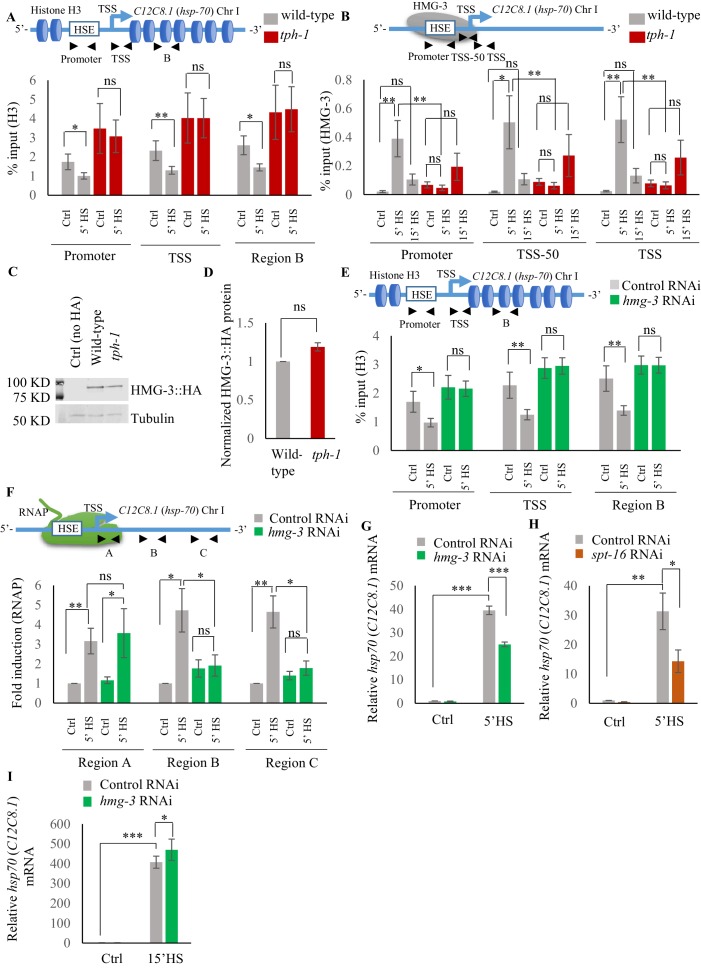
Characterizing H3 and FACT occupancy across hsp genes in wild-type and tph-1 mutant animals under control and heat shock conditions.(A) Top: Schematic of hsp70 (C12C8.1) gene regions within the Promoter (same as in Figure 4D: −166 to −78), Transcription Start Site (TSS: +40 to +131) and gene body (Region B: +475 to +583) assayed for histone H3 occupancy. Bottom: Occupancy of histone H3 (% input) at the Promoter, TSS and Region B upon 5 min at 34°C (n = 9 experiments). (B) Top: Schematic of hsp70 (C12C8.1) gene regions within the Promoter (same as Figure 4D: −166 to –78), region upstream of Transcription Start Site (TSS-50: −77 to +42) and Transcription Start Site (TSS: +40 to +131) assayed for HMG-3 occupancy in wild-type and tph-1 mutant animals. Bottom: HMG-3 occupancy (% input) across Promoter, TSS-50 and TSS following 5 and 15 min at 34°C (n = 13 experiments). The specificity and efficiency of pull-down under control conditions was ascertained. (C) Representative western blot using anti-HA antibody showing the specificity of the HA antibody (lane 1: Ctrl are wild-type animals that do not express HA-tagged proteins), and HMG-3 protein levels in wild-type and tph-1 animals under control conditions. Tubulin was used as the internal control. (D) Quantified levels of HMG-3 in wild-type and tph-1 animals (n = 3 experiments). Protein levels were normalized to that in control animals. (E) Top: Schematic of hsp70 (C12C8.1) gene: same regions as in A were assayed for H3 occupancy. Bottom: Occupancy of histone H3 (% input) in Promoter, TSS and in Region B of hsp70 (C12C8.1) under control conditions and following 5 min at 34°C, in control-RNAi treated animals and hmg-3-RNAi treated animals (n = 9 experiments). (F) Top: Schematic of hsp70 (C12C8.1) gene: regions as in Figure 4C, that is close to the beginning (Region A: +25 to +185), middle of gene (Region B: +475 to +583) and towards 3’-UTR (Region C:+1645 to +1835) were assayed for occupancy by RNAP following hmg-3 knock-down by RNAi. Bottom: Fold change in RNAP at beginning, Region B and Region C following 5 min heat shock at 34°C (n = 5 experiments). % input values were normalized to that in control-RNAi treated animals at these regions. (G) hsp70 (C12C8.1) mRNA levels in control-RNAi treated and hmg-3 -RNAi treated animals following a 5 min heat shock at 34°C (n = 6 experiments). (H) hsp70 (C12C8.1) mRNA levels in control-RNAi treated and spt-16 -RNAi treated animals following a 5 min heat shock at 34°C (n = 4 experiments). (I) hsp70 (C12C8.1) mRNA levels in control-RNAi treated and hmg-3 -RNAi treated animals following a 15 min heat shock at 34°C (n = 4 experiments). Data show Mean ± Standard Error of the Mean. *, p<0.05; **, p<0.01 ***, p<0.001; (paired Students t-test). A, B, E, F: ANOVA with Tukey’s correction. (D) (G–I) paired Student’s t-test. ns, non-significant.